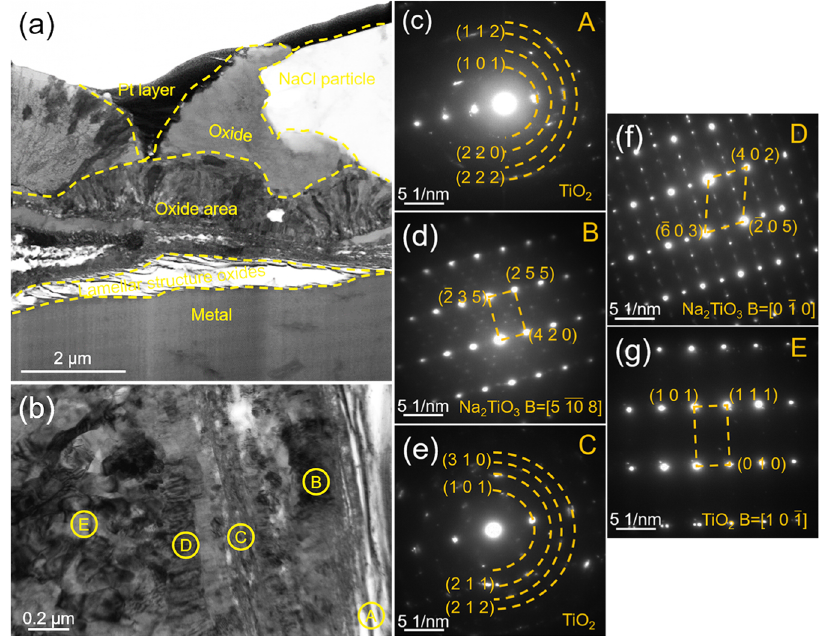
Fig. 5 TEM results of Ti exposed to the continuous NaCl solution spraying for 5 h at 600 °C. a STEM cross-section morphology, b inner layer TEM enlarged view, c SAED patterns of area A, d SAED patterns of area B, e SAED patterns of area C, f SAED patterns of area D, and g SAED patterns of area